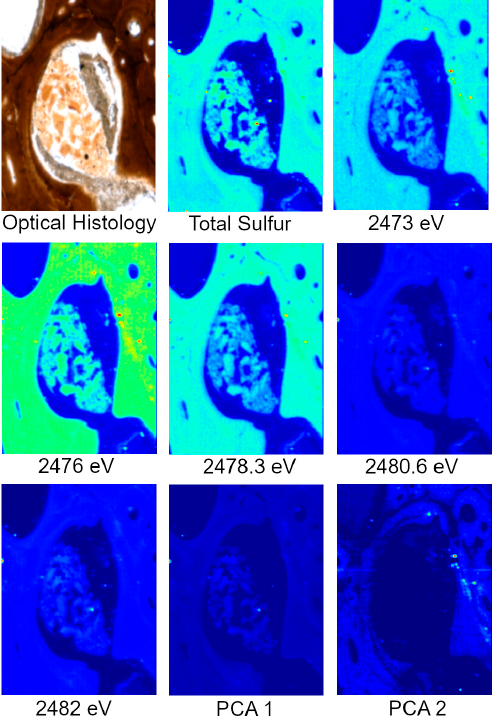
Figure 2. Optical histology, total S, S species, and PCA of S species maps from MOR 1125 ( T. rex ). Optical histology identifies tissues of interest for scanning, in this case Haversian tissue (remodeling) and possible medullary bone (reproductive). Total S represents the distribution of all S species within the area of interest. Various S maps are taken at known energies of important S species within bone, both organic and inorganic. PCA analyses show the greatest difference between the maps, usually indicating differences in concentration and species. XANES are taken based on highlighted areas of species differences in PCA 2 to identify exact S species.